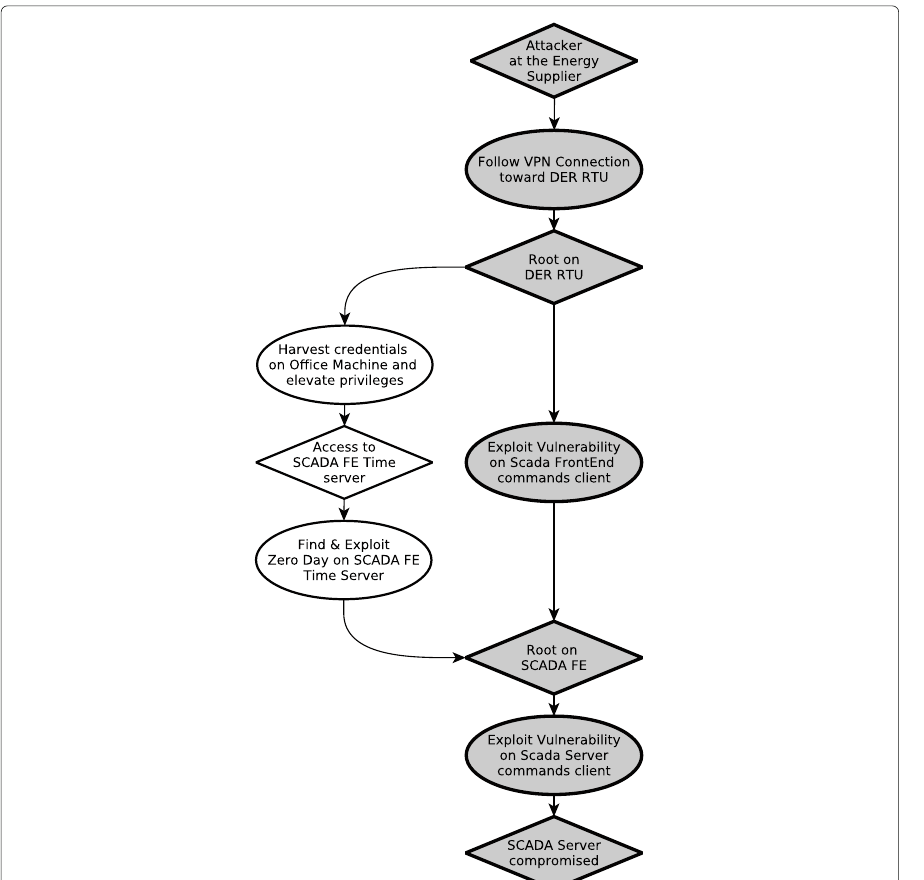
Fig. 10 Aggregated attack graph of an attacker positioned at the energy